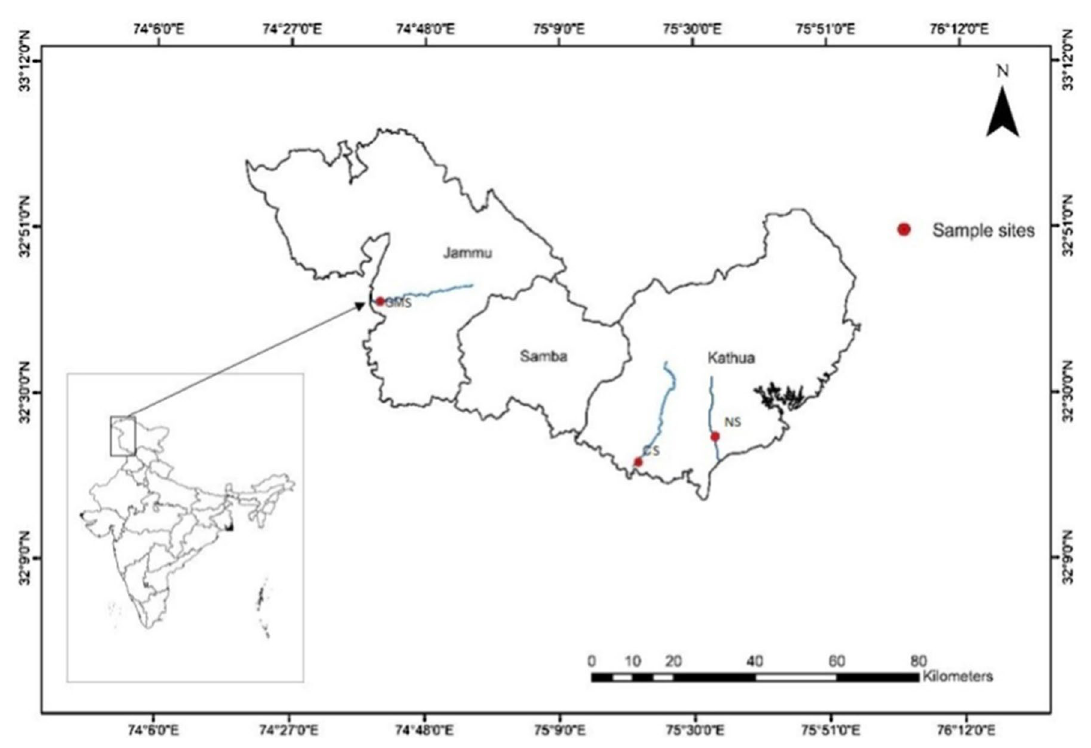
Fig. 1 Map showing the location of different